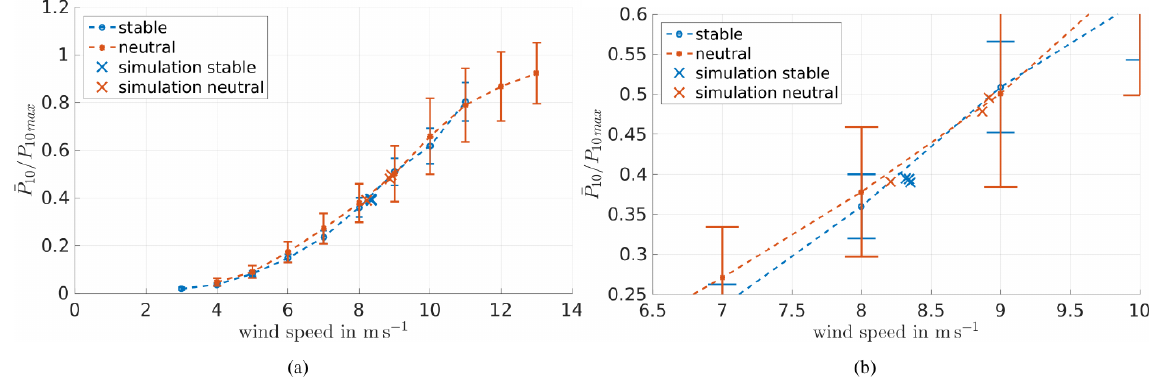
Figure 11. (a) Power curve, normalised by maximum 10min power, determined from measurement data including standard deviation in comparison to the results of the simulation (marked by × ). (b) Enlargement of panel (a) . The standard deviation is plotted again in Fig. 12.